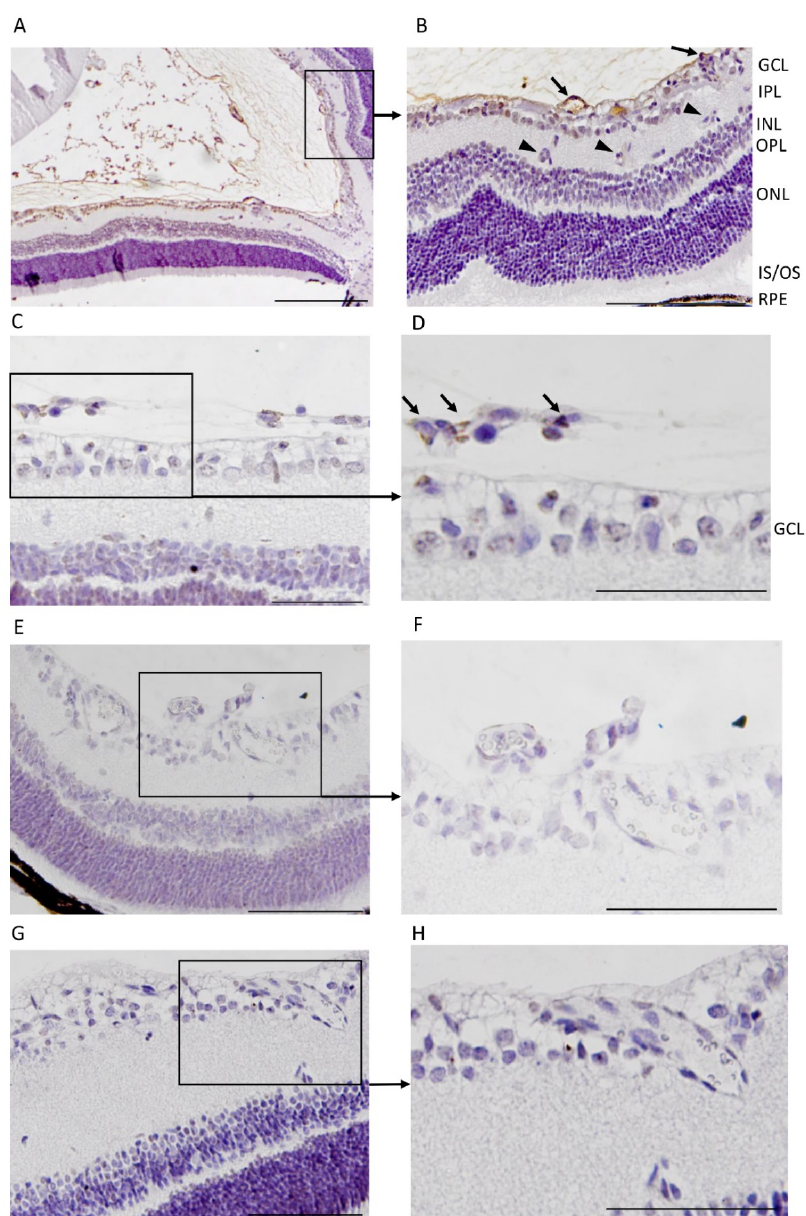
Figure 1. CAR-peptide (in brown) homes to pathological neovasculature in the mouse oxygen-induced retinopathy (OIR) model . Immunohistologically stained (for the detection of fluorescein in the peptide) cross sections of whole eye reveals that the systemically injected (intraperitoneal) CAR peptide ( A – D ) homes into the pathological preretinal blood vessels (arrows) whereas some of the normal blood vessels in the retina are not targets for CAR homing (arrowheads). Less hom- ing was seen in animals injected with the m CAR-peptide ( E , F ), while no CAR peptide accumulation was detected in a normal (normoxia) retina after the systemic administration of the peptide ( G , H ). ( D ) GCL, ganglion cell layer; IPL, inner plexiform layer; INL, inner nuclear layer; OPL, outer plexiform layer; ONL, outer nuclear layer. ( N = 12 retinas in two separate experiments). Scale bars represent 100 µm ( A ) and 200 µm ( B – H ).